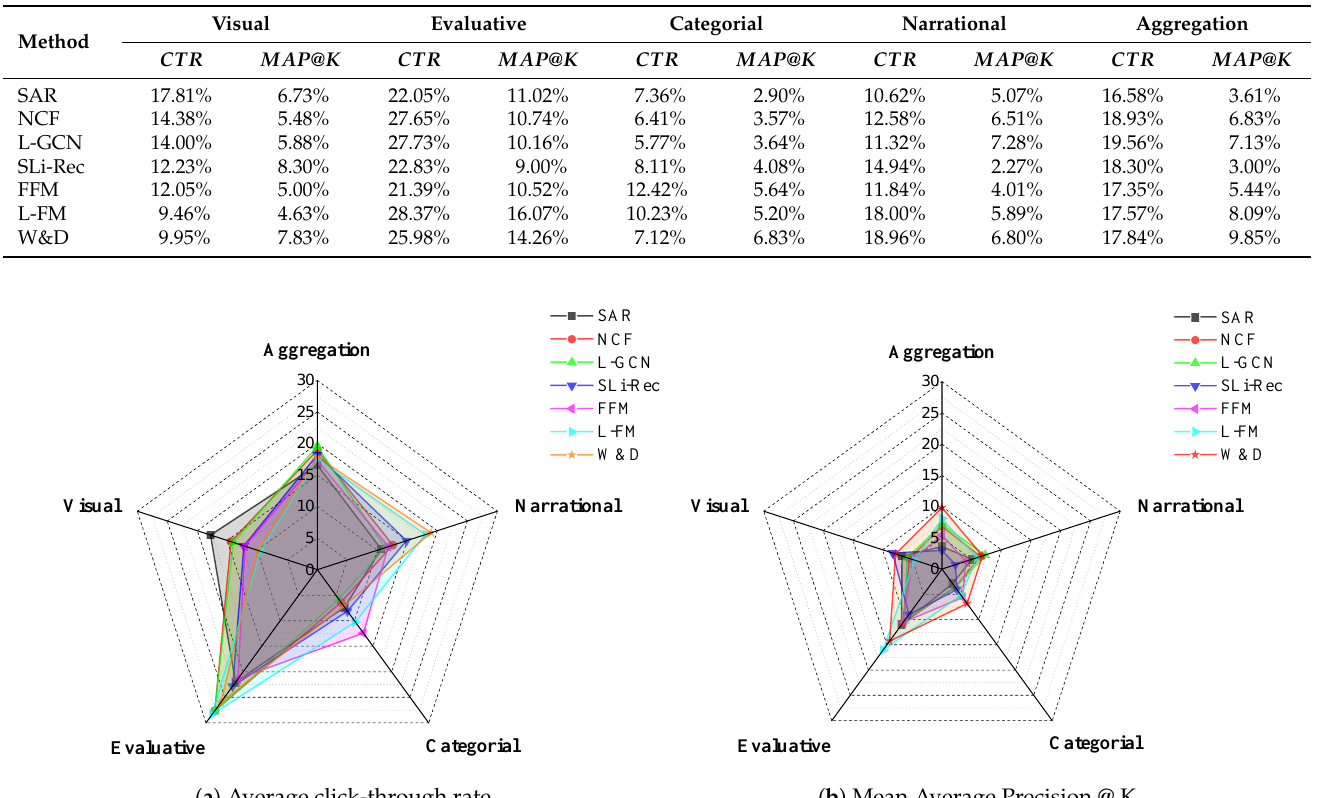
Figure 14. Comparing the degree of improvement in different